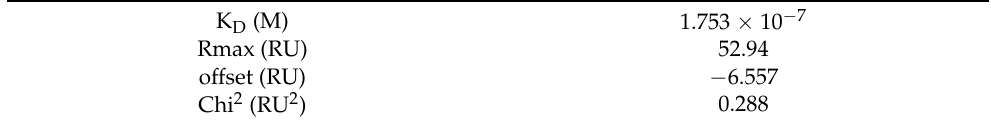
Table 2. Affinity analysis of immobilized of E6 protein and anti-HP-1 IgY antibodies with different concentrations.